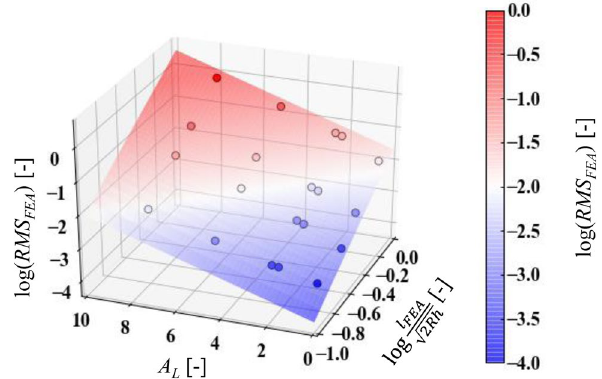
Fig. 11 Root-mean-square ( RMS ) error of indentation-derived FEA elastic modulus ( M ) with normalized mesh size ( l FEA ∕ anisotropy index ( A L